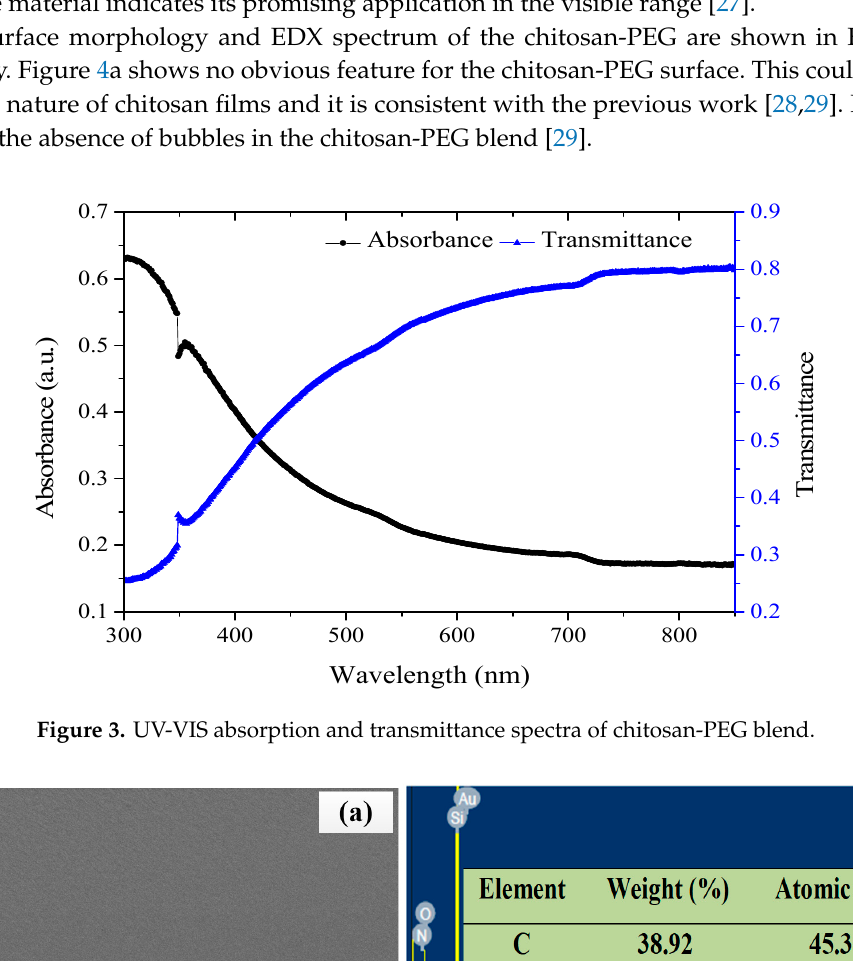
Figure 4. ( a ) FESEM image of chitosan-PEG, ( b ) energy-dispersive X-ray (EDX) spectrum and elemental composition of chitosan-PEG.